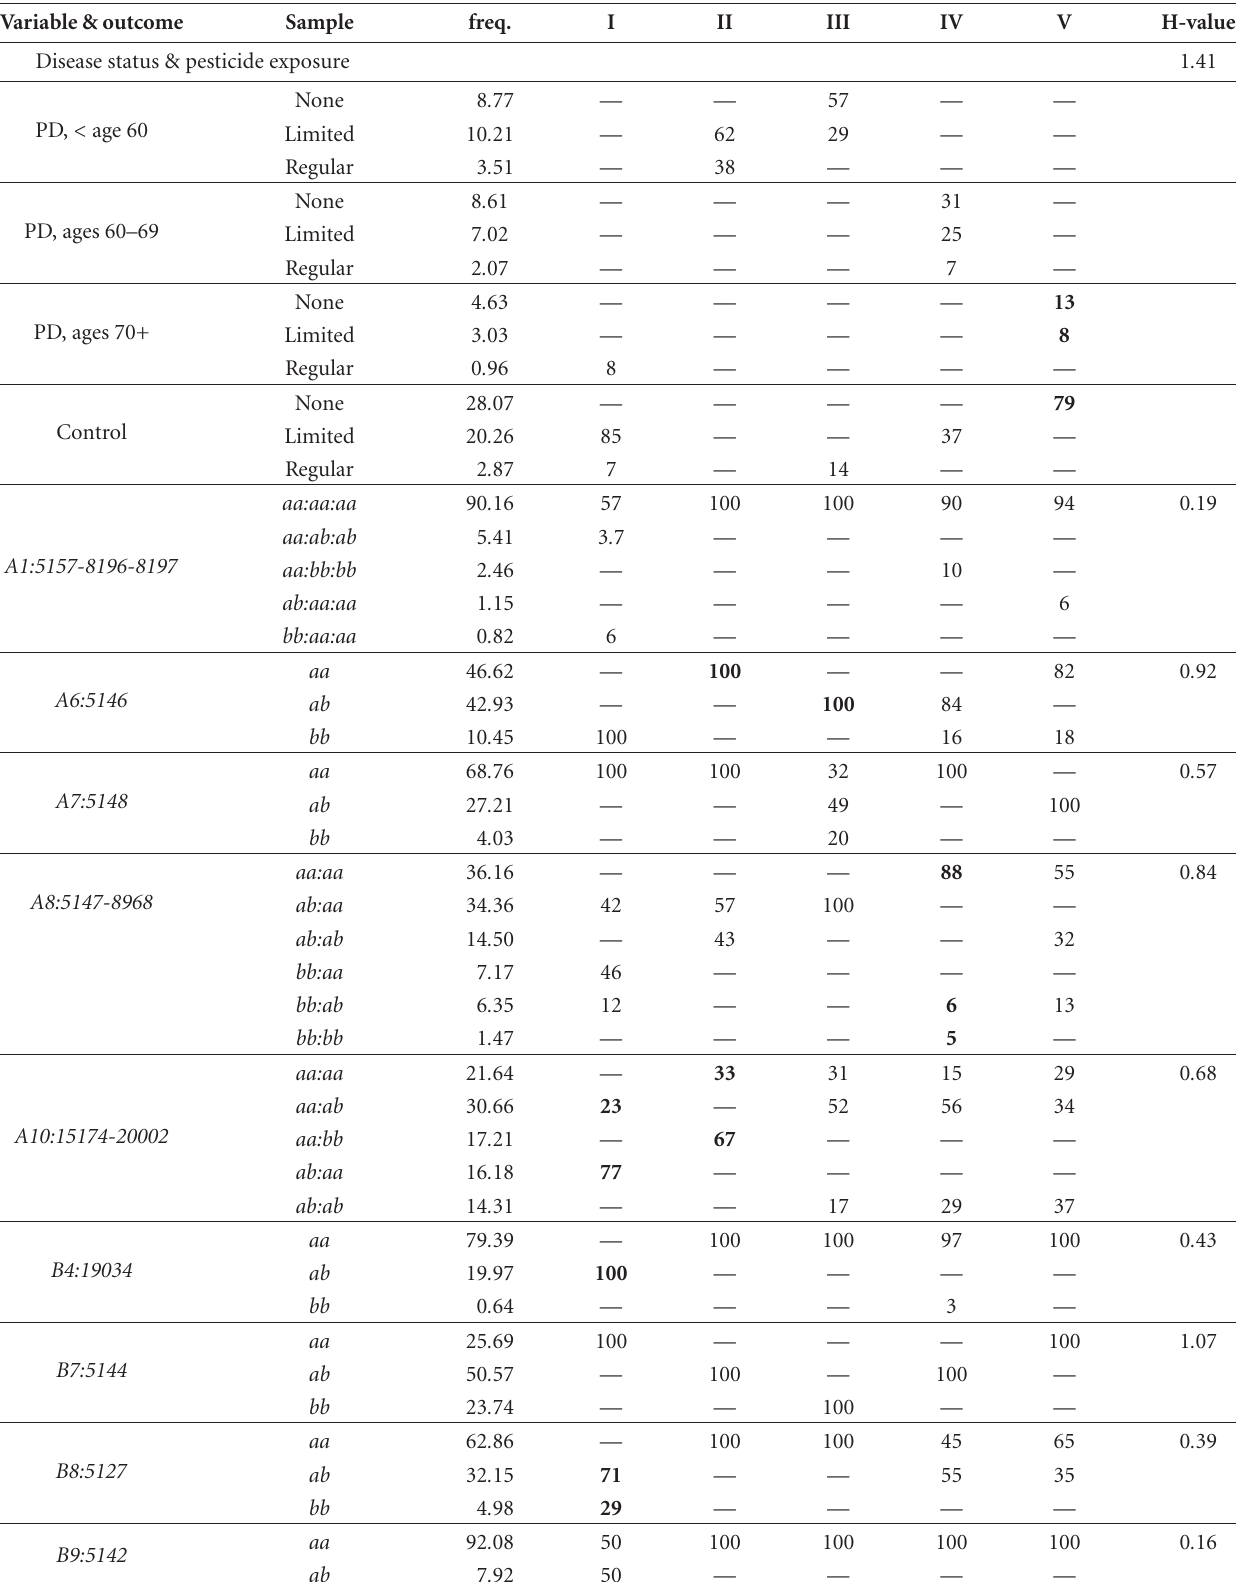
Table 2: Probabilities for each variable outcome found for GoM groups I to V. Group I: “robust to pesticide exposure,” group II “early onset PD, regular exposure,” group III: “early onset PD, limited exposure,” group IV “late onset PD, limited exposure,” group V “low risk, no exposure.” Variable & outcome Disease status & pesticide